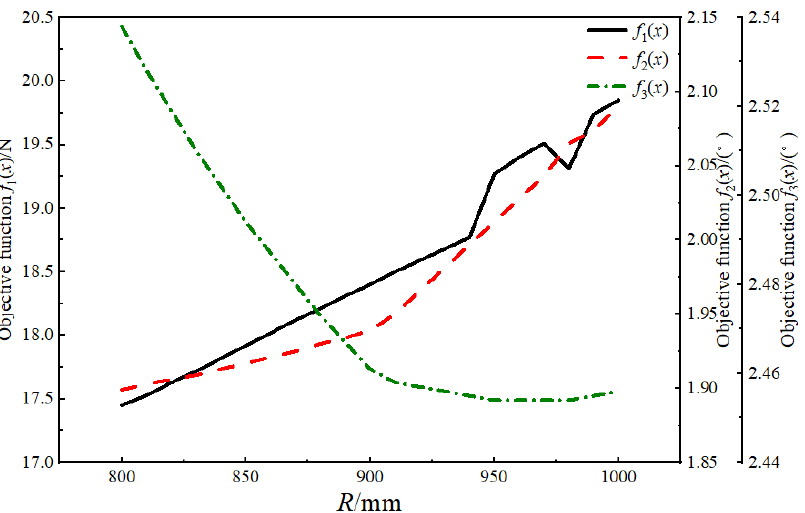
Figure 7. Variation curve of the objective function with the distribution circle radius R of the geometric center of the universal joint of the fixed platform.